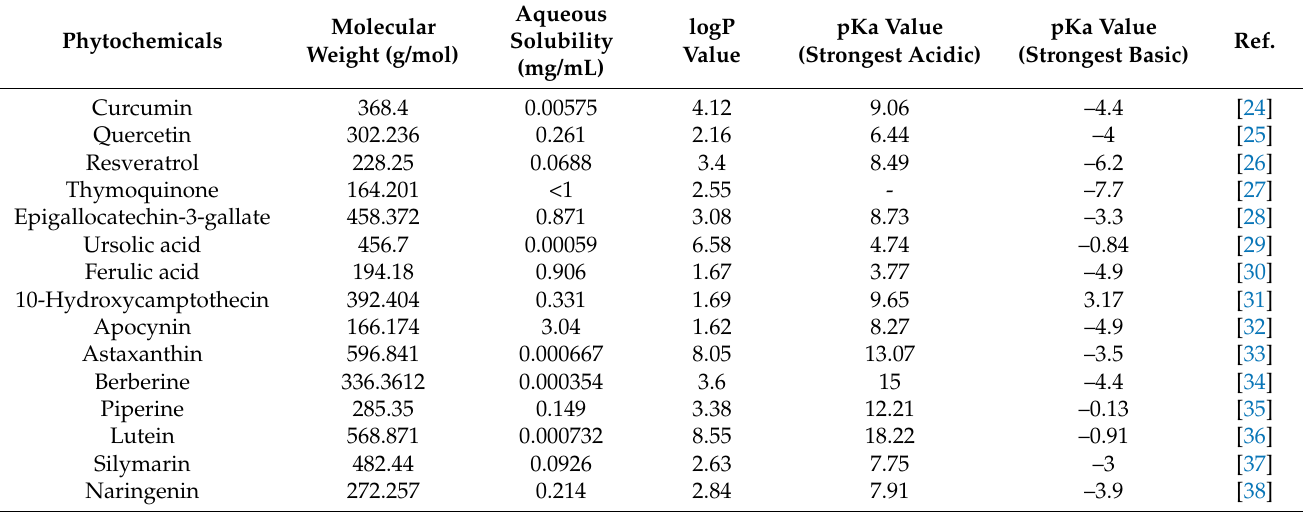
Table 1. Physicochemical characteristics of phytochemicals reviewed in this manuscript that are intended for oral administration.